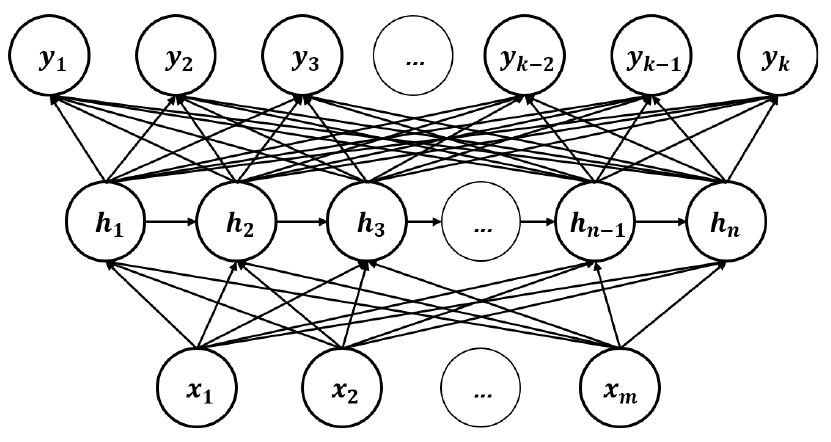
Figure 3. RNN architecture by